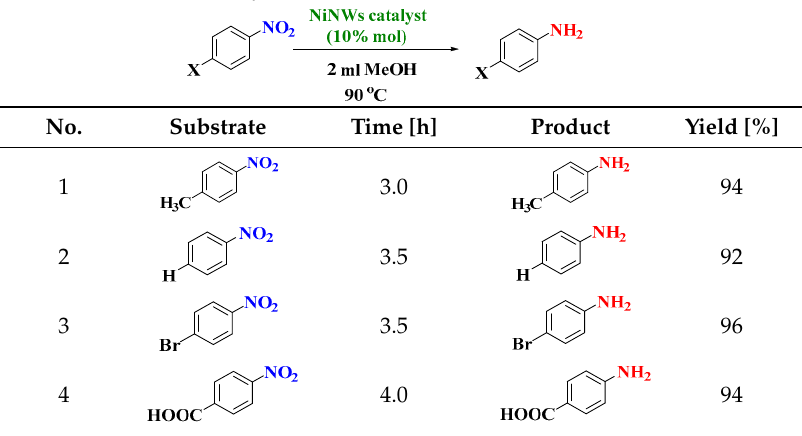
Table 6. Synthesis of the substituted anilines a .